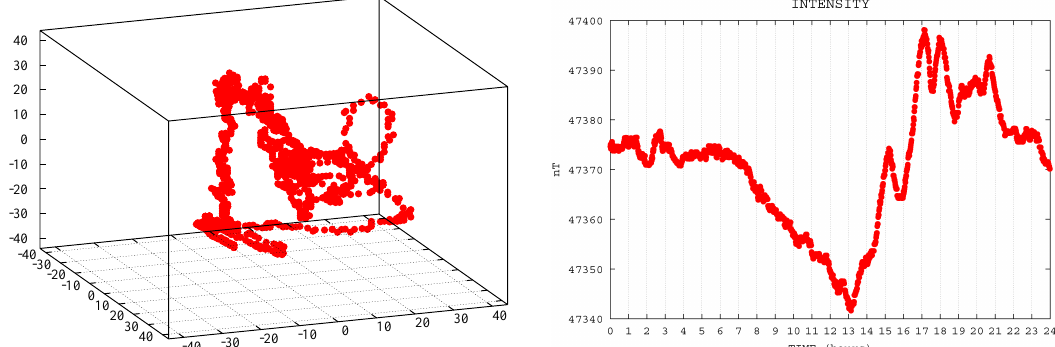
Fig. 1. Calibration triplet B 1 , B 2 , B 3 and the geographical North-East-Down frame { u i } . The unit vectors e 1 , e 2 , e 3 (defining the physical axes) are nearly orthogonal, and each e i is close to corresponding u i . The large gray ball represents the variation of vector V (the one to be measured after calibration); small balls radii represent the measurement error εb ; value δb is the upper bound for all | B i − B k | , i , k = 1, 2, 3